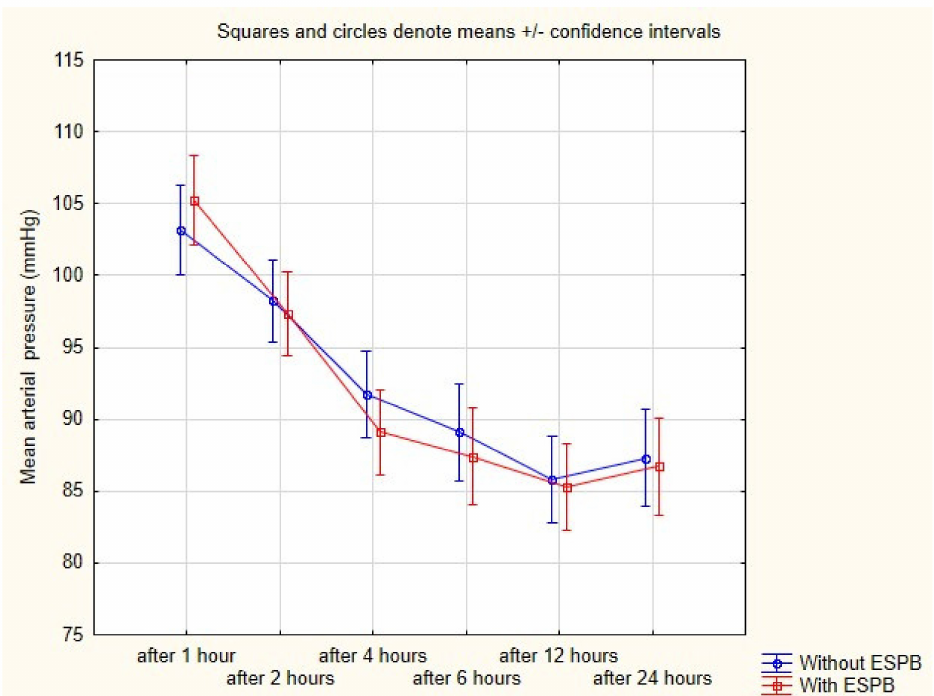
Figure 3. Mean arterial pressure after operation in both